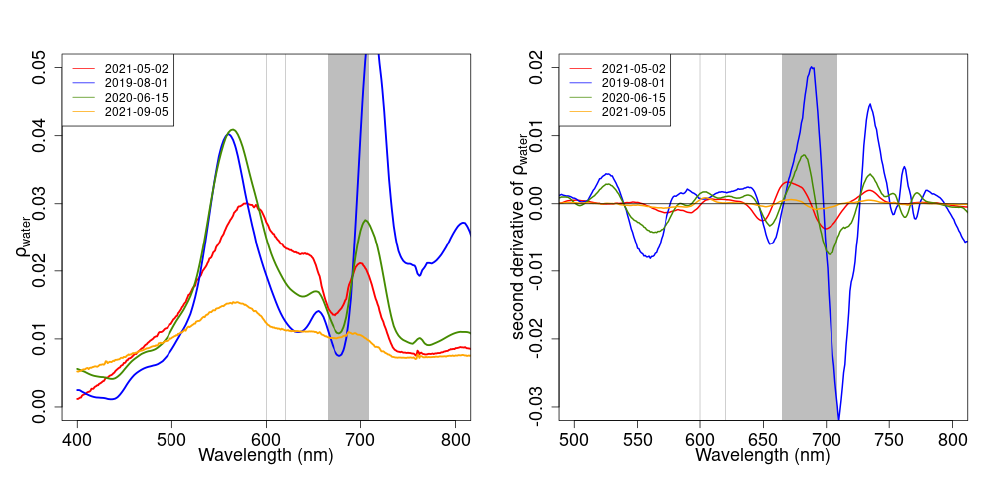
Figure 11. Average reflectance spectra for a diatom bloom (2021-05-02) and from cyanobacteria blooms (2019-08-01, 2020-06-15 and 2021-09-05) ( left ) and second derivatives for each spectra ( right ). Gray vertical lines at 600 and 620 nm and shaded areas between 665 and 709 nm show the wavelengths of interest.